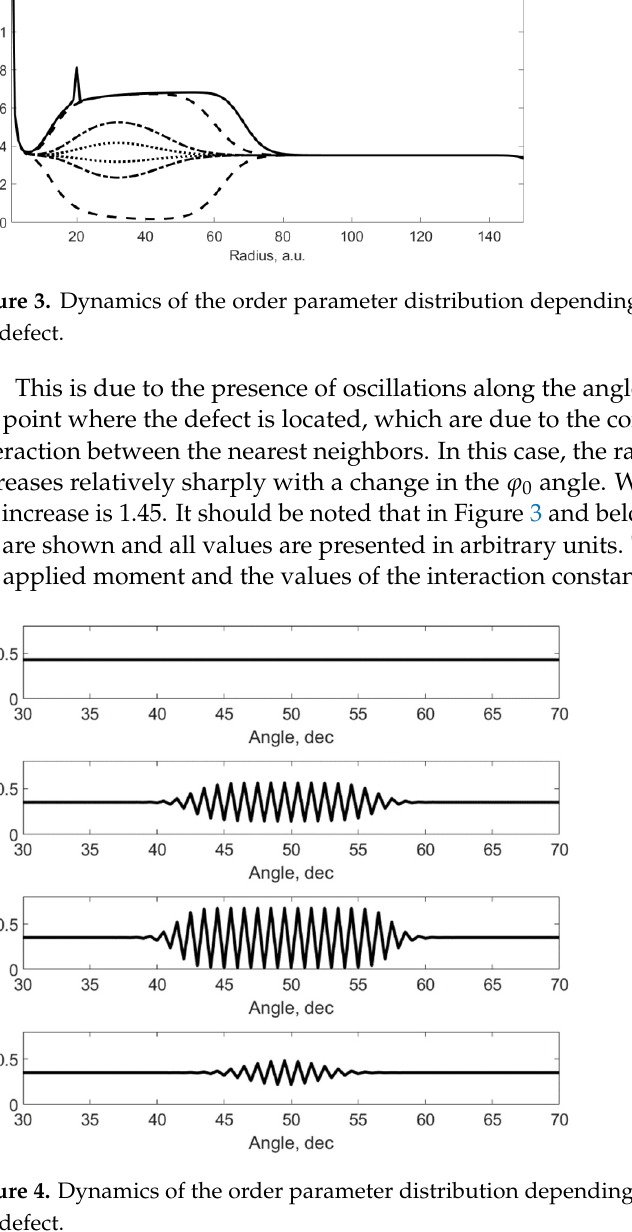
Figure 5. Dynamics of changes in the oscillatory process in time. 4. Influence of the Higher-Order Invariants